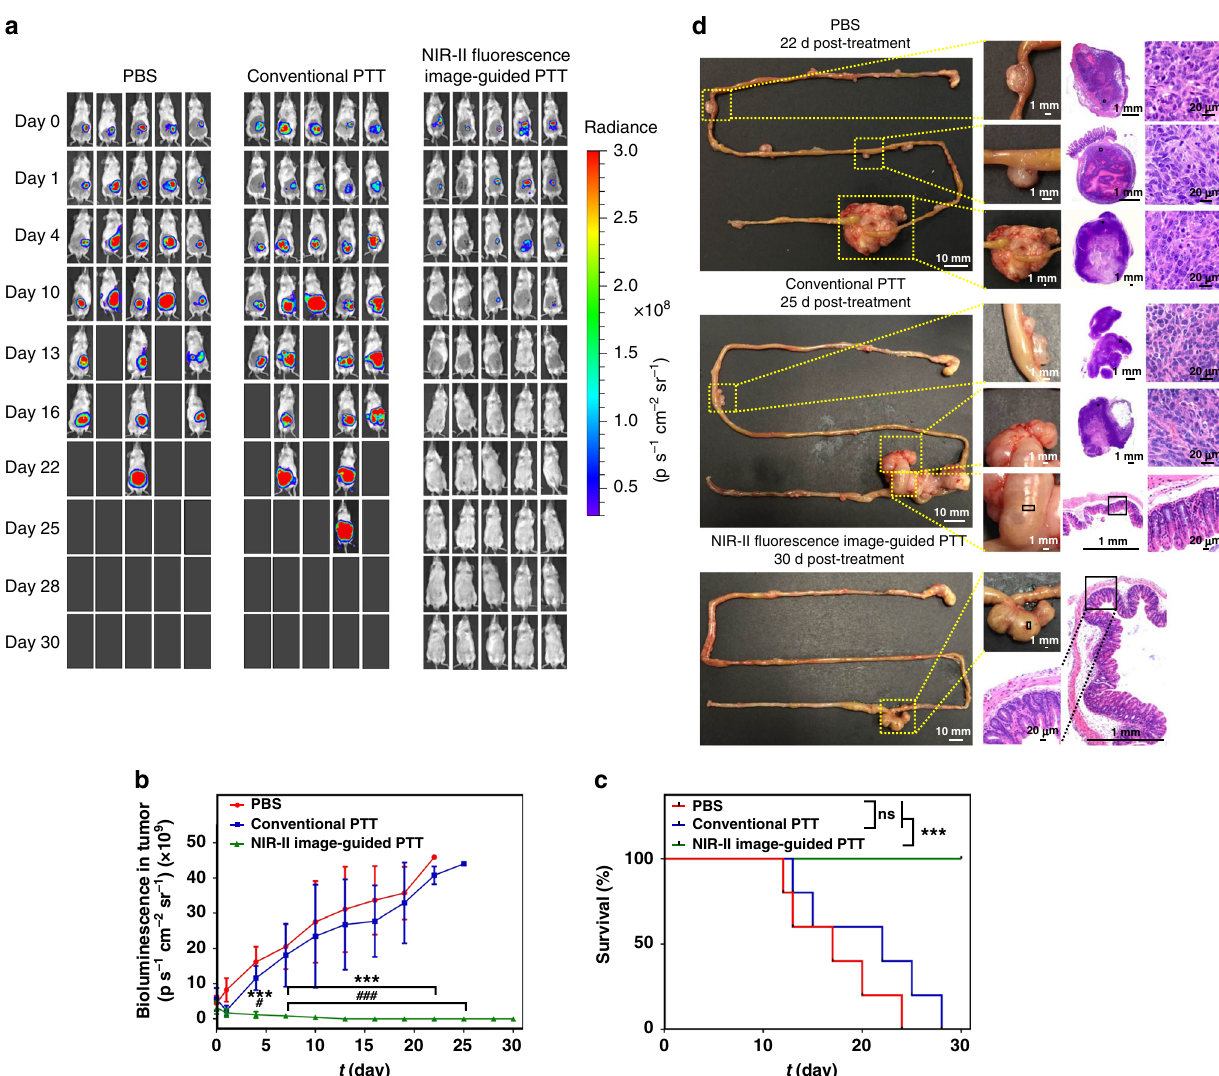
Fig. 9 Therapeutic ef fi cacy of intraoperative NIR-II image-guided PTT by BPBBT NPs. a The in vivo bioluminescence imaging of BALB/c mice bearing orthotopic CT26 colon cancer before (day 0) or after different treatment ( n = 5). In the group of NIR-II fl uorescence image-guided PTT, mice received i.v. injection of BPBBT NPs (20 mg kg − 1 ). After 30 h, primary and metastatic tumor was visualized under NIR-II imaging followed by PTT with the optimized doses according to the tumor sizes. In the group of conventional PTT, mice were i.v. injected with BPBBT NPs (20 mg kg − 1 ). After 30 h, only primary lesion visualized by eye received PTT with the optimized doses according to the tumor sizes. In both treated groups, the cecum was repositioned following PTT. The skin was closed with suture. In PBS group, mice received i.v. injection of PBS without further treatment. b Tumor growth curves of mice bearing orthotopic CT26-Luc colon cancer following different treatment measured by the bioluminescence. Data are presented as Mean ± S.D. ( n = 5). Statistical signi fi cance was calculated via two-way analysis of variance (ANOVA) with a Tukey post-hoc test. *** p < 0.001 between the NIR-II image-guided PTT group and PBS group. # p < 0.05, ### p < 0.001 between the NIR-II image-guided PTT group and conventional PTT group. c Kaplan – Meier survival curve